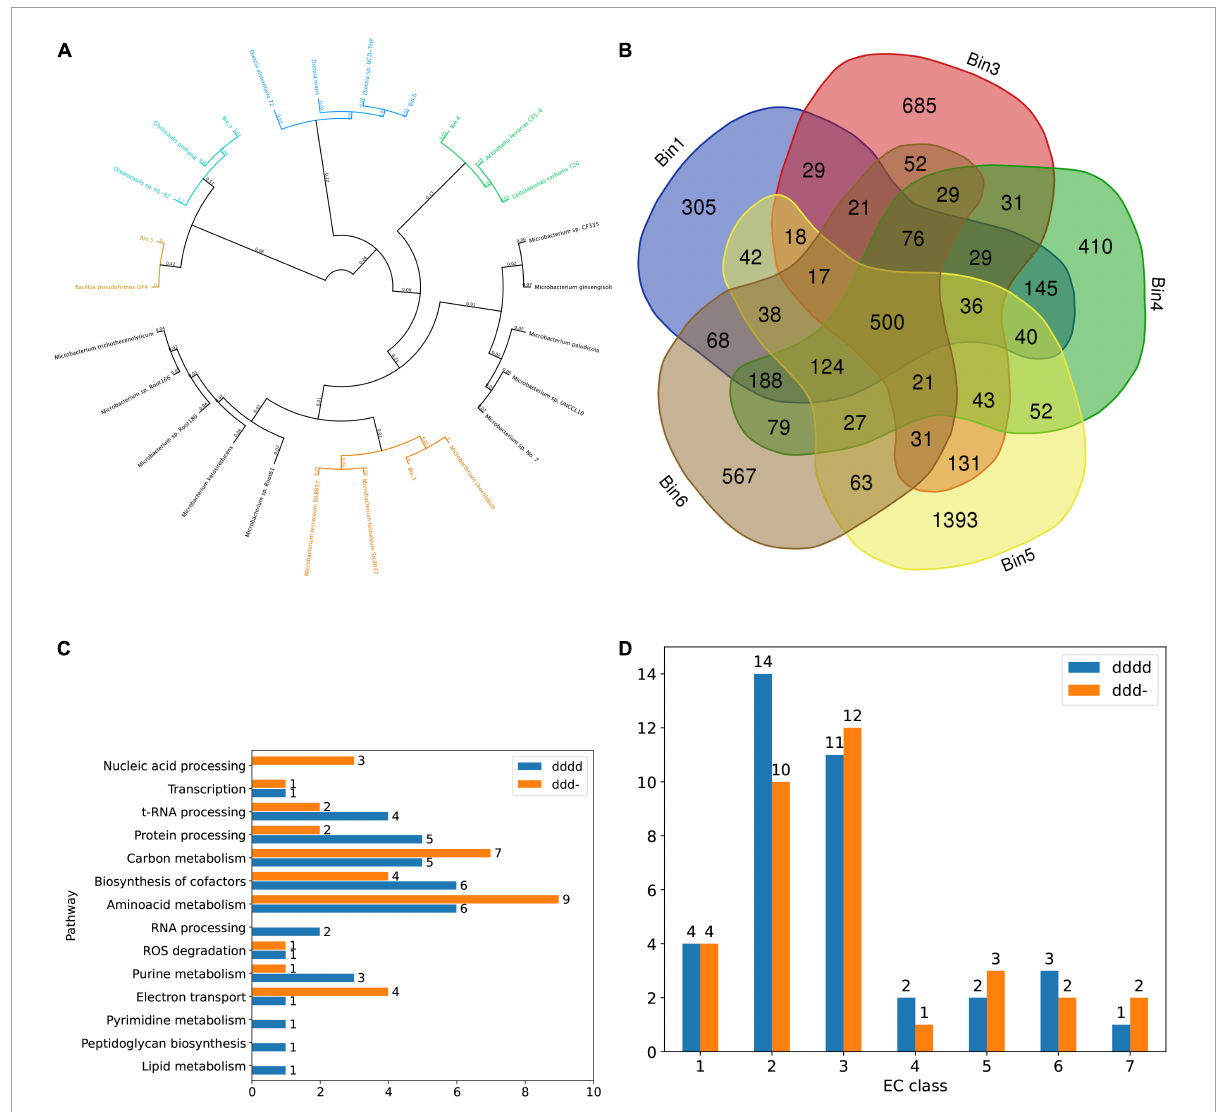
FIGURE4 (A) Phylogenetic tree of bins from the pH7 anodes (numbers indicate substitutions per site). (B) Venn diagram showing common annotations. (C) The number of Bin.4-unique genes in different metabolic pathways. (D) The number of Bin.4-unique genes across EC classes for two deepest levels of EC classifications (dddd and ddd-